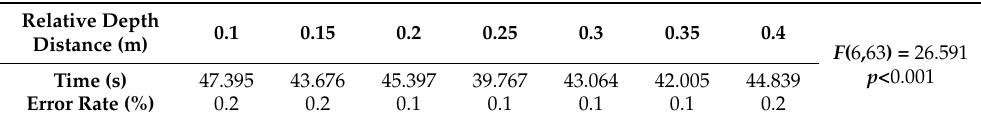
Table 17. The average time and error rate of completing the task by the depth distance of different relative positions of the information display layer.